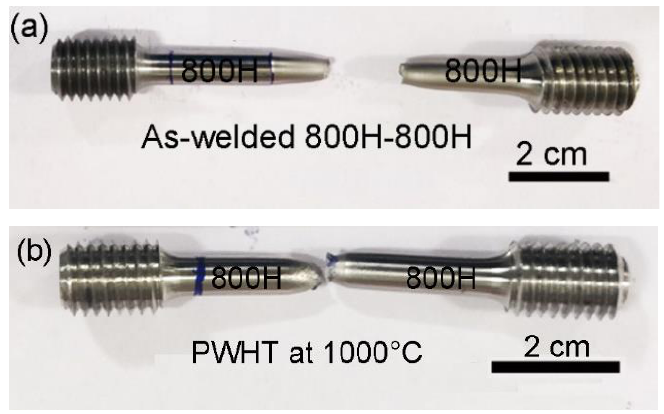
Figure 6. Tensile failure location of the ( a ) as-welded and ( b ) PWHT weld joints.